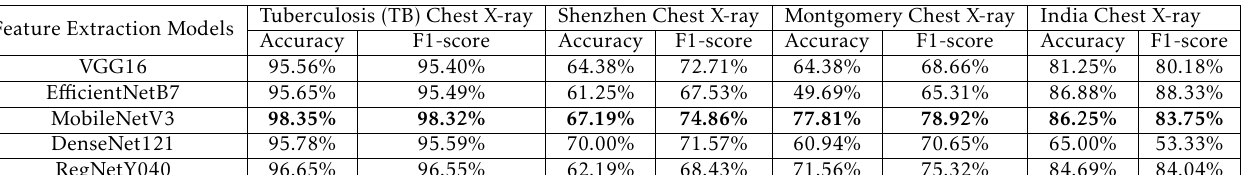
Table 6. Performance evaluation between models on the selected datasets